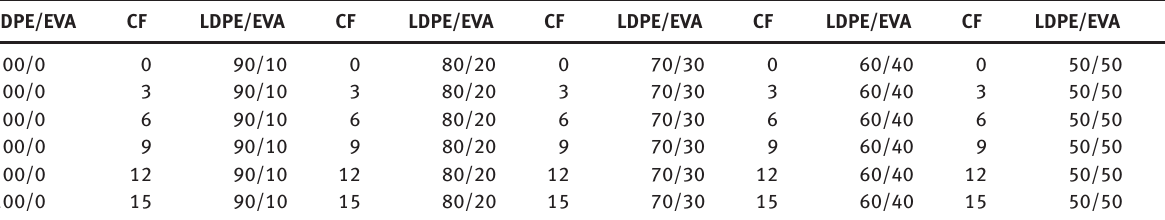
Table 2: Carbon filler content (in wt%) of the